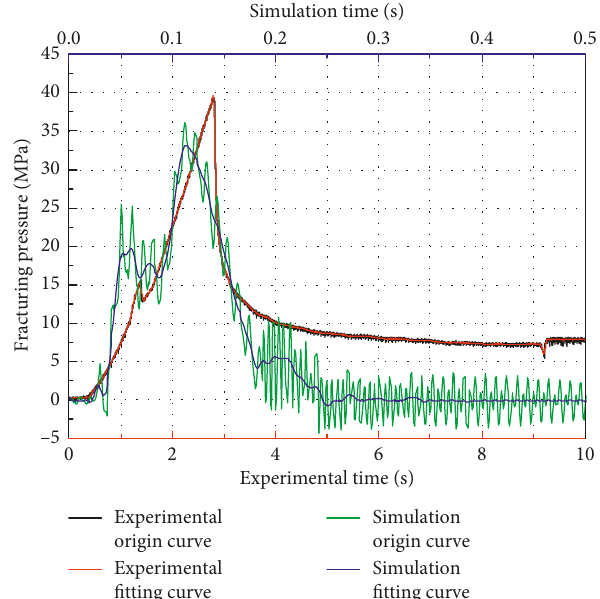
Figure 12: Numerical and experimental comparison of fracturing pressure at α � 40 ° .